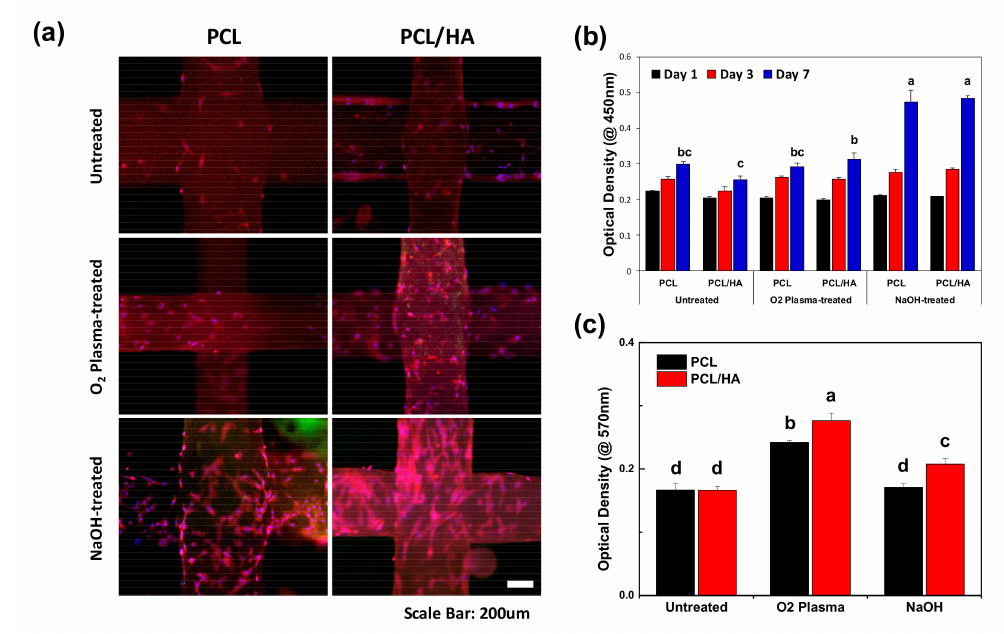
Figure 3. In vitro study of hDPSCs on the scaffolds. ( a ) Fluorescence microscopy image of the hDPSCs attached on the scaffolds on day 3. Both O 2 plasma and NaOH treatments enhanced cell attachment of the scaffolds. ( b ) Cell proliferation on days 1, 3, and 7 using a WST-1 assay (n = 7, ANOVA, Duncan’s multiple range test, p < 0.05). At day 7, the NaOH-treated scaffolds exhibited significantly enhanced cell proliferation. Same letters indicate that there is no significant difference between samples. ( c ) Measurement of protein adsorption on the scaffolds after 24 h of incubation with 1% bovine serum albumin (BSA) solution (n = 5, ANOVA, Duncan’s multiple range test, p < 0.05). O 2 plasma treatment greatly promoted protein adsorption ability of the scaffolds. Same letters indicate that there is no significant difference between